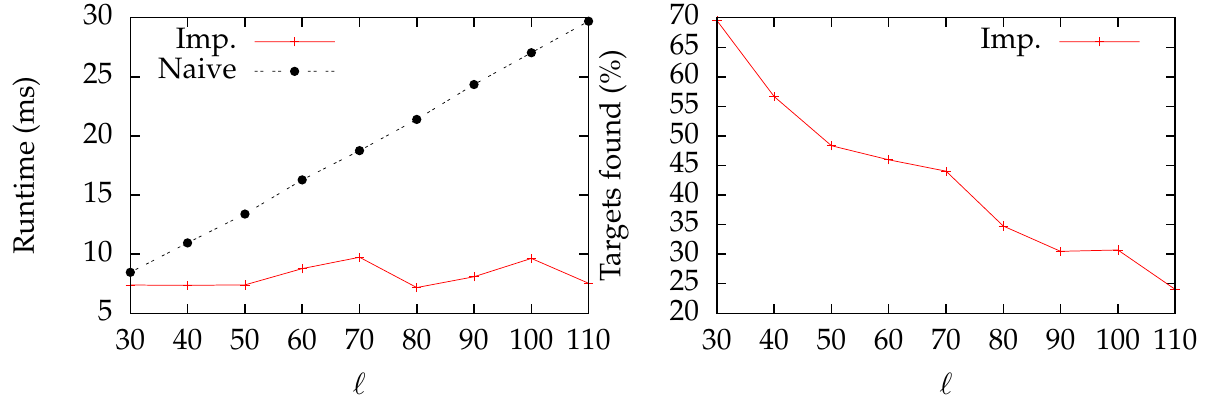
Figure 6. Evaluation on a star-shaped graph with the query vertex s in the center. Each axis of length ‘ 2 of the star is assigned exactly one target vertex u whose distance to s is ‘ i 2 / 2 . Since the arcs all · |T | have unit costs, the length between two nodes ( u , v ) is the number of nodes of the shortest path from u to v . Naive and Imp. are measuring Dijkstra’s algorithm and Dijkstra’s algorithm combined with our solution, respectively.